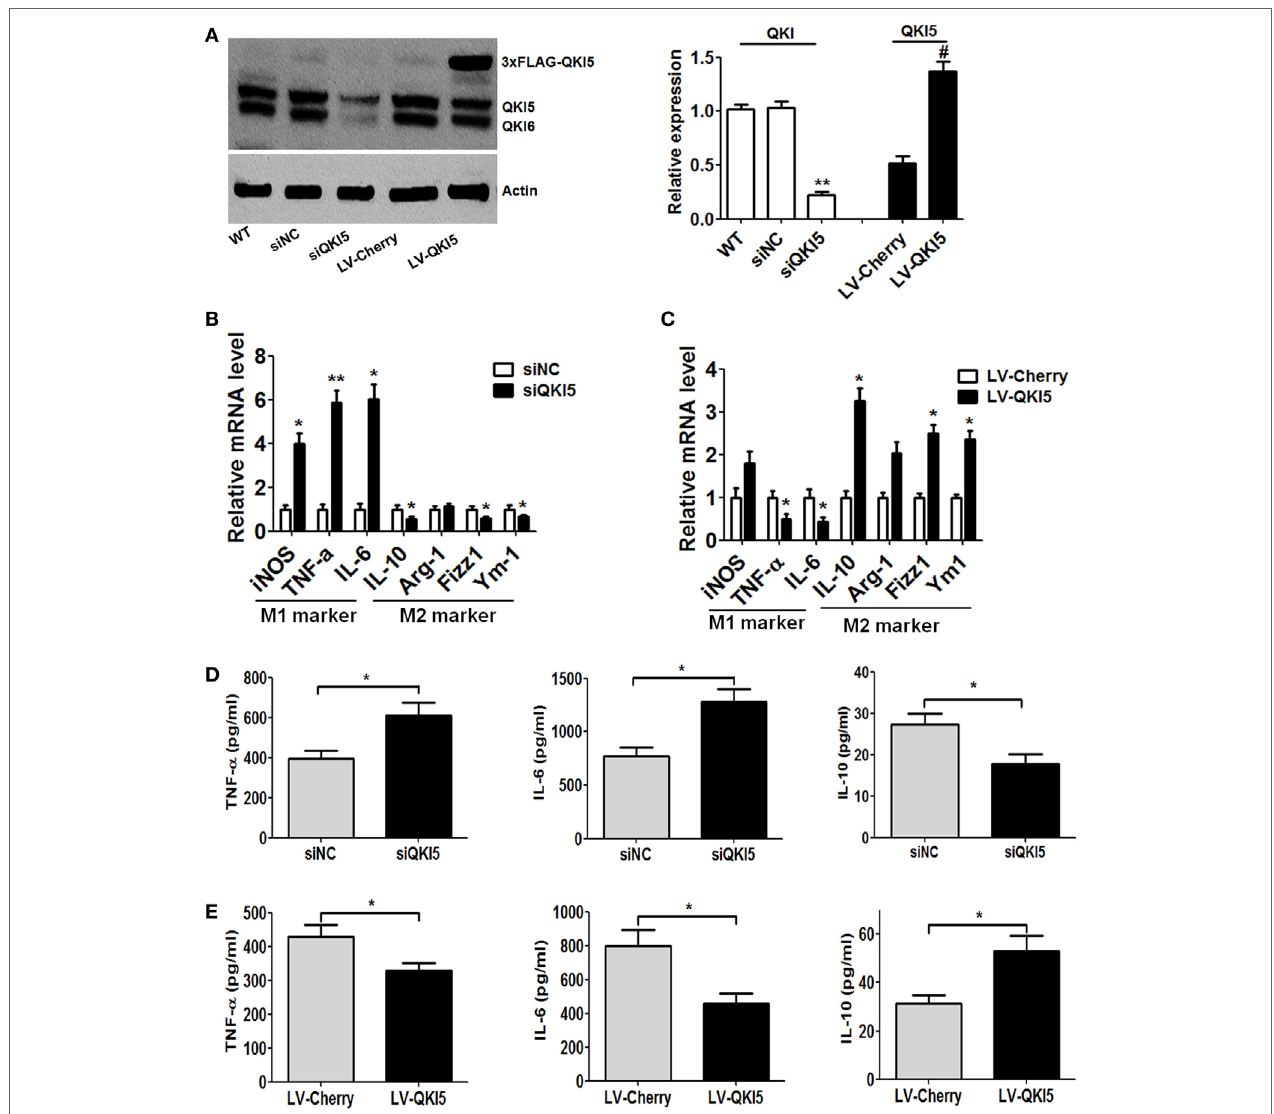
FigUre 2 | Dysregulation of quaking (QKI) expression influenced the production of macrophage lineage-specific cytokines. (a) Western blots were performed to determine the effects of QKI knockdown (siQKI5 and siNC was a scramble control) or overexpression (LV-QKI5, and LV-Cherry was a control) in RAW 264.7 cells using an anti-QKI antibody. One representative immunoblot is shown (on the left) and the graph (on the right) presents quantification of the band intensity for immunoblots from three independent experiments. ** p < 0.01 versus WT control; # p < 0.05 versus LV-Cherry group. (B,c) Real-time PCR analysis of relative mRNA expression of the M1 markers (iNOS, TNF- α , and IL-6) and M2 markers (IL-10, Arg-1, Fizz1, and Ym1) by QKI silencing (B) or overexpression (c) RAW 264.7 cells stimulated with 1 µg/ml lipopolysaccharide (LPS) for 16 h. (D,e) Enzyme-linked immunosorbent assay (ELISA) of the production of TNF- α , IL-6, and IL-10 by QKI-silenced (D) or overexpressed (e) RAW 264.7 cells stimulated for 24 h with 1 µg/ml LPS. All the bars represent the mean of measurements from three independent experiments, and the error bars indicate ± SEM. * p < 0.05, ** p <